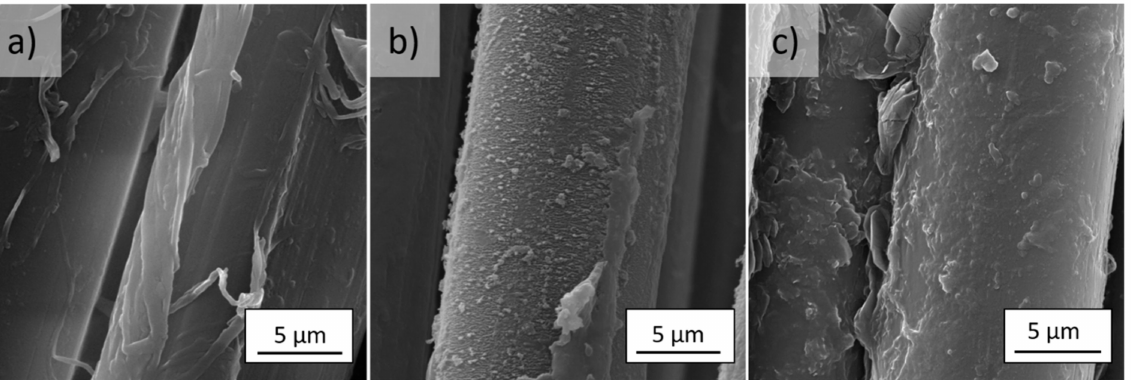
Figure 3. SEM images of ( a ) reference, ( b ) plasma treated, and ( c ) polydopamine modified p Ar fibers (magnification of 10,000 ×